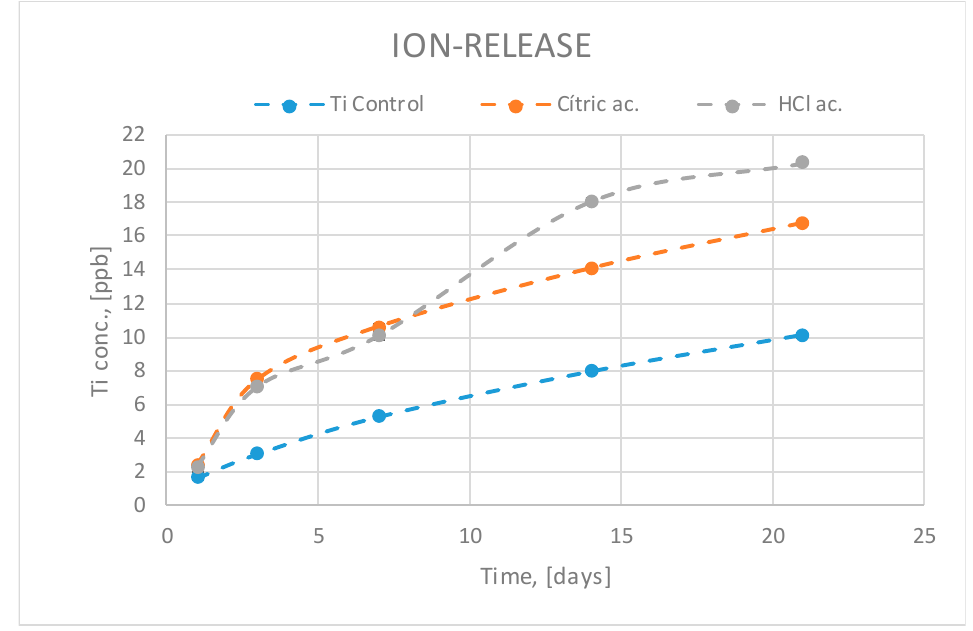
Figure 4. Titanium ion release at different times as a function of surface treatment.